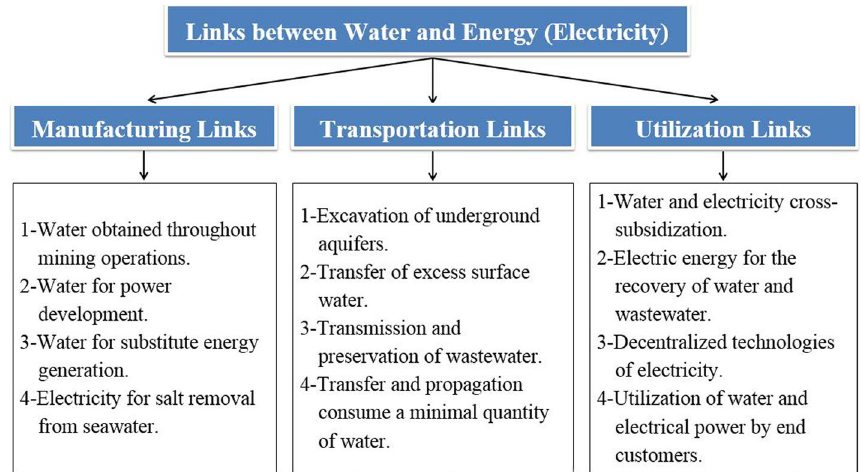
Fig. 3 Basic flow pattern from environment, water, and other energy